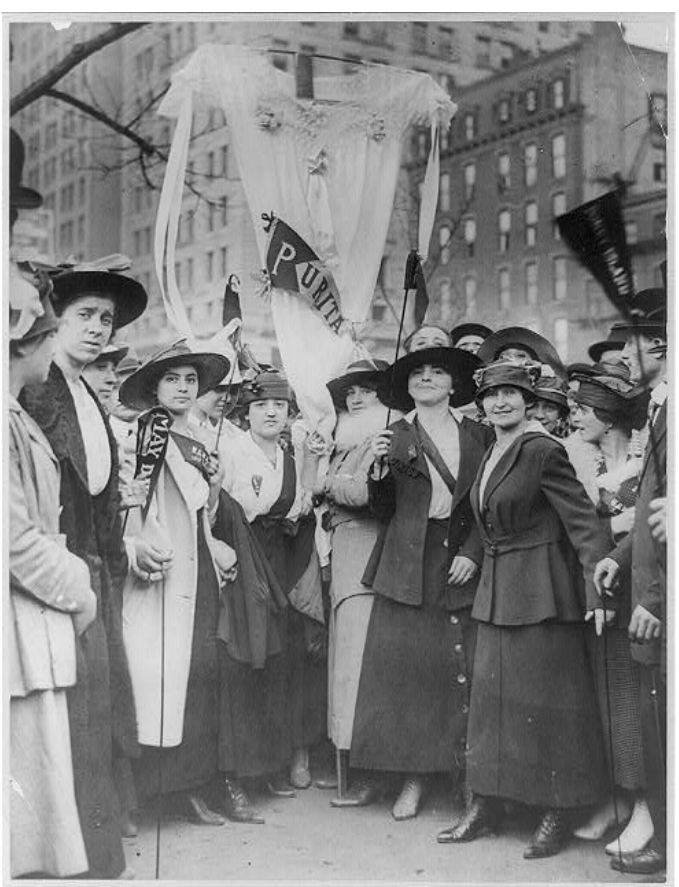
Figure 9. Bain News Services. Garment workers parading on May Day, 1916, New York. Library of Congress.